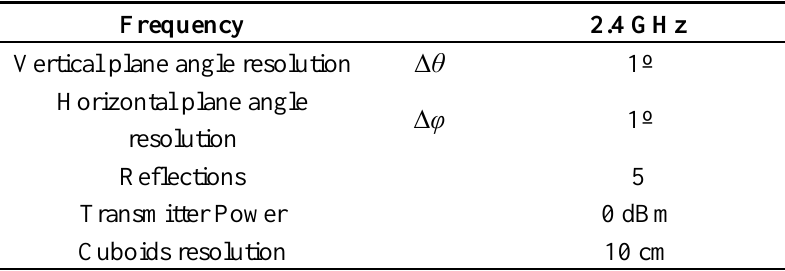
Table 2. Parameters in the ray launching